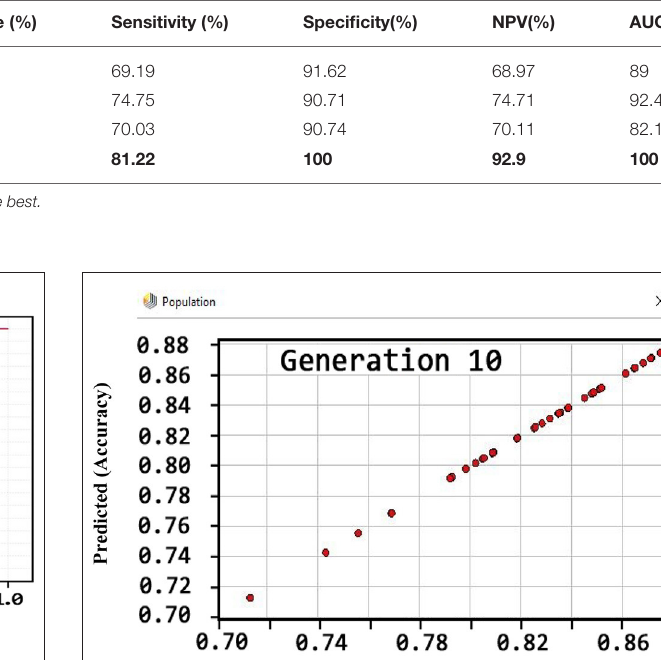
TABLE 7 | The comparison of the methods based on the Z-Alizadeh Sani dataset in this study.